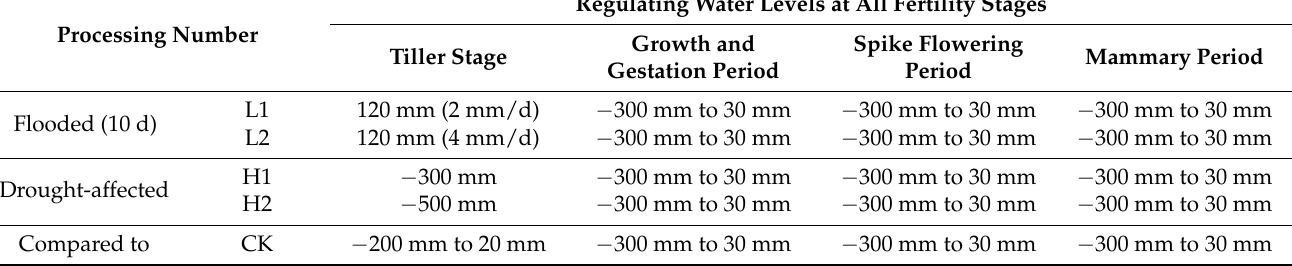
Table 1. Rice water level management trial